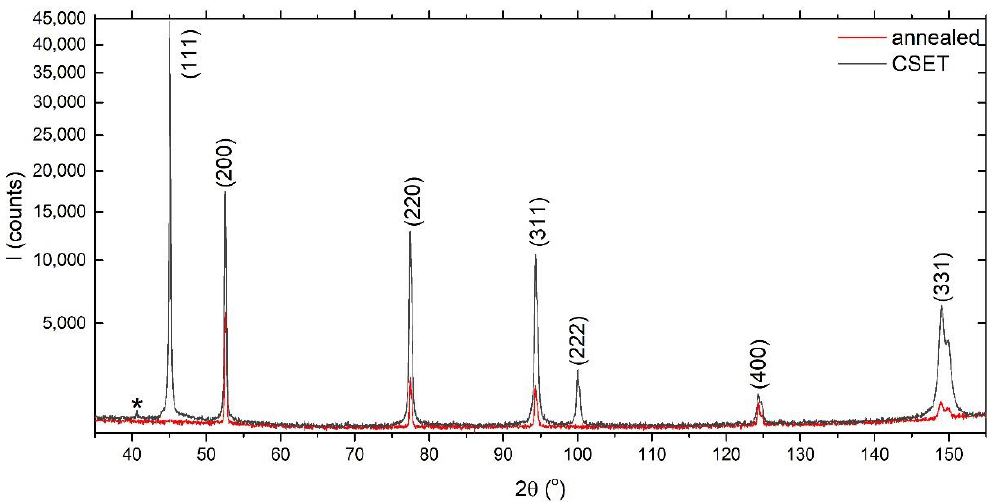
Figure 8. The X-ray diffraction pattern recorded from the annealed sample (in red) and from the tube wall on the RD plane of the CSET-processed sample (in black).